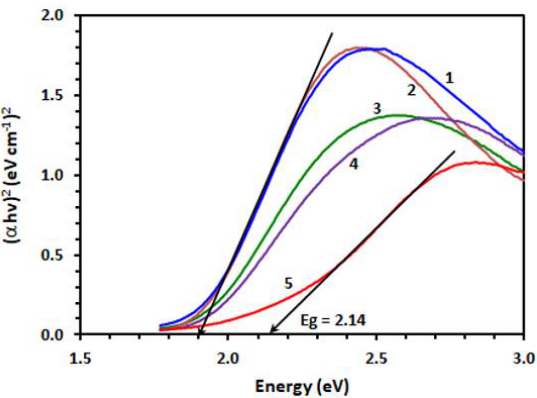
Figure 3. Tauc plots of energy (h) against ( αh )2 for CT complex of CLA with TOZ (1), VAN (2), SEL (3), DAS (4) and OLA (5).